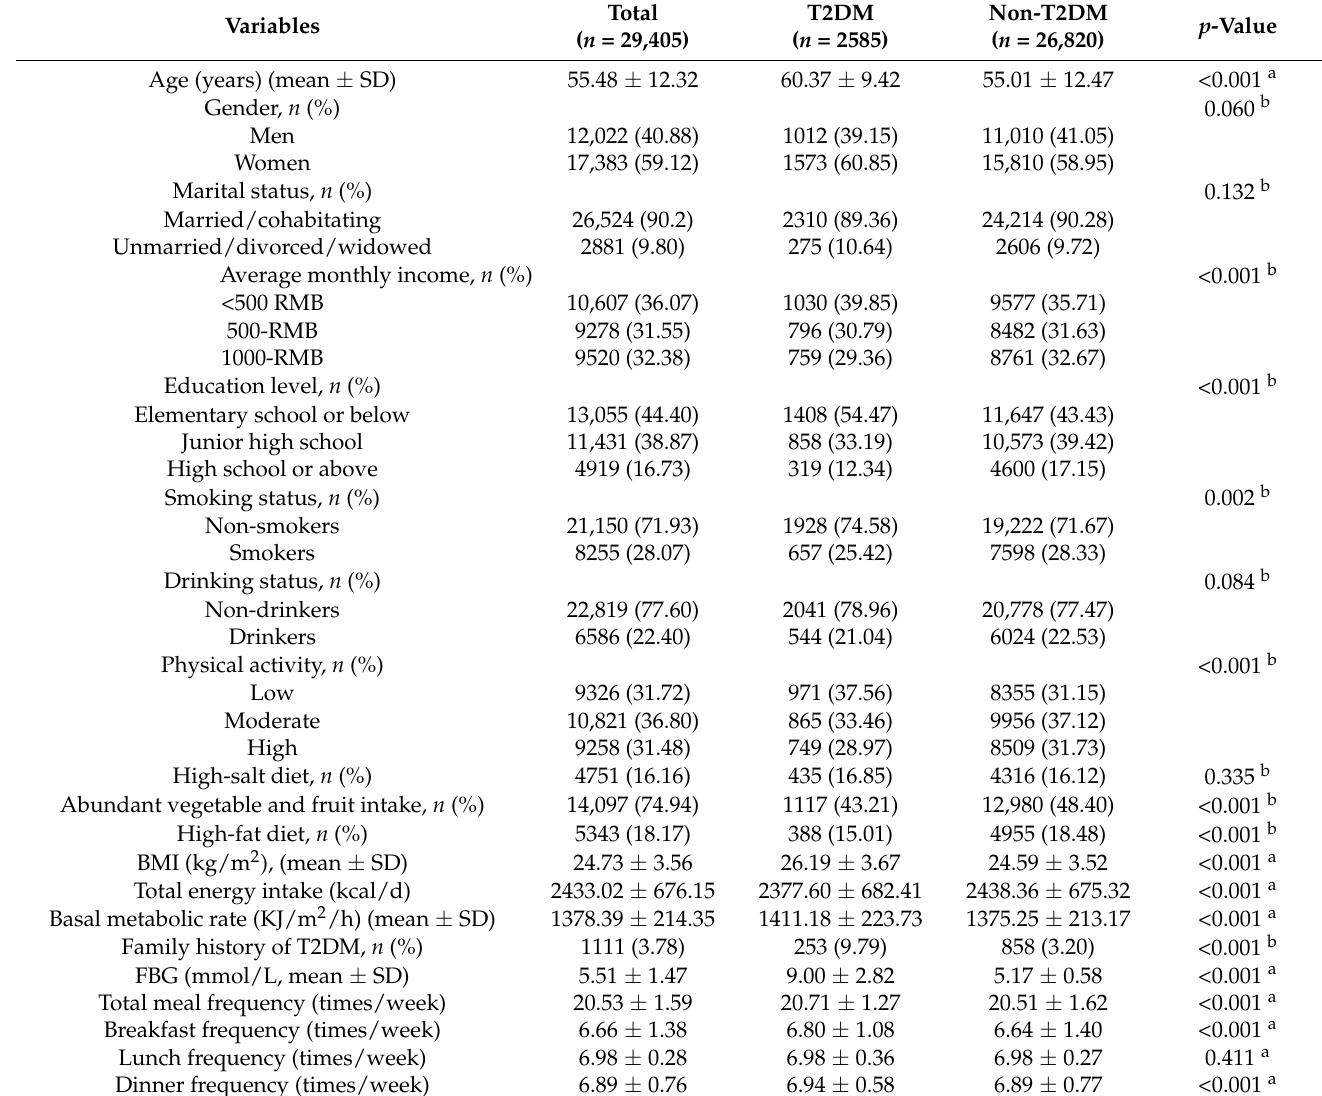
Table 1. Basic characteristics of participants according to T2DM ( n =